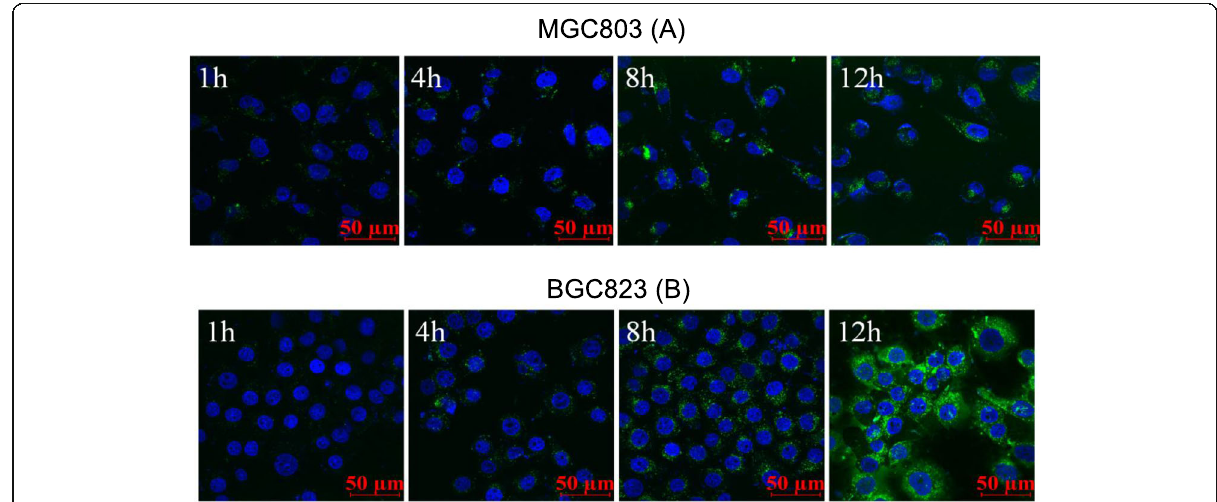
Fig. 2 In vitro cellular time-dependent uptake of CSO-SA micelles in MGC803 ( a ) and BGC823 ( b ) cells for 1, 4, 8, 12 h, respectively (blue, Hoechst 33342; green, FITC; scale bar = 50 μ